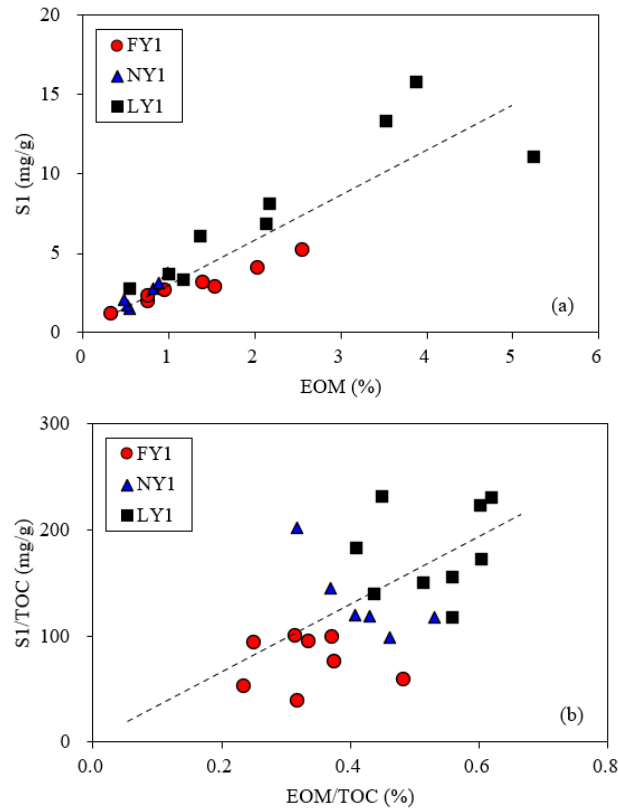
Figure 16. Relationship between EOM and S1 ( a ) and relationship between S1/TOC and EOM/TOC ( b ) based on the data of the studied samples.